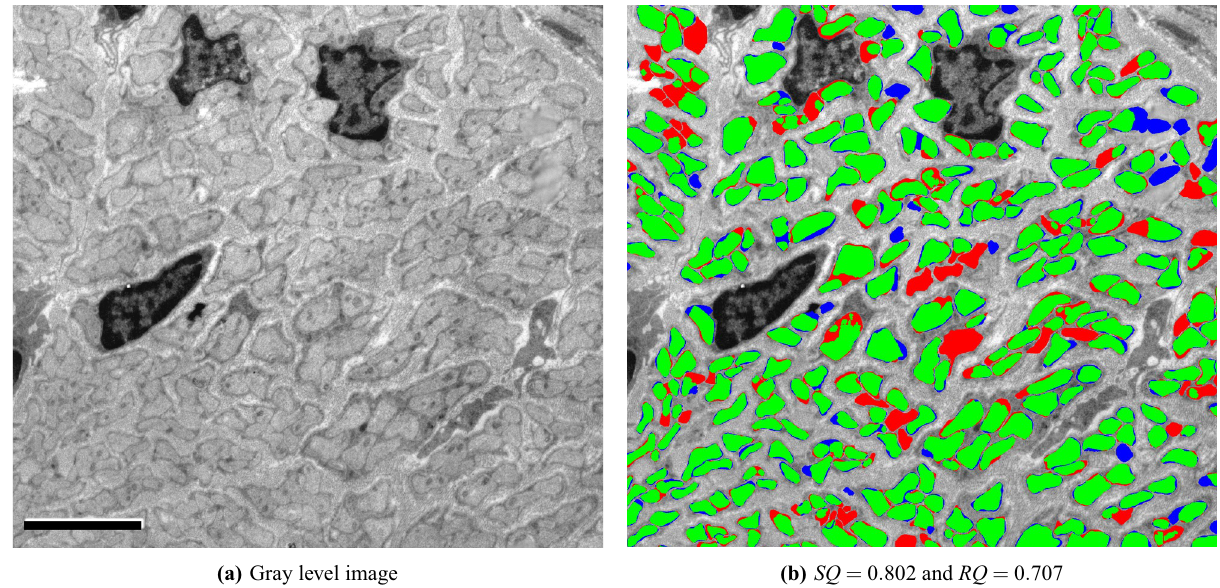
Figure 10. Fully automated evaluation on a low-contrast image with indistinct fiber borders and clumped patterns. TP, FP, and FN regions are shown in green, blue, and red, respectively. Scale bar: 4 µ m.